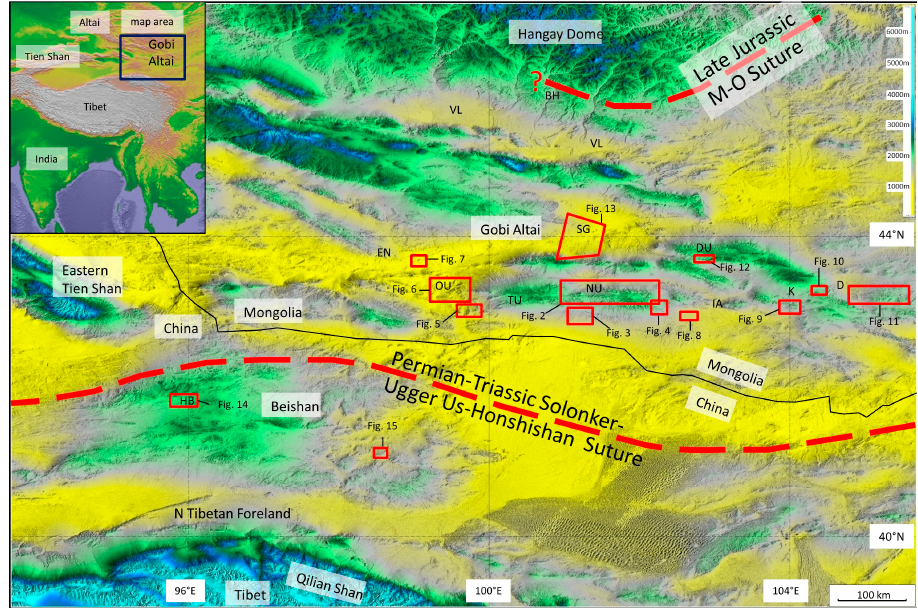
Figure 1. DEM of Gobi Corridor region of southern Mongolia and northern China showing locations of folded basinal compartments (red boxed areas) and subsequent figures (SRTM-90 topographic data). Each location contains contractionally deformed Permian-Jurassic siliciclastic sedimentary rocks unconformably overlain by Cretaceous-Tertiary/Quaternary alluvial sediments that are typically undeformed or less deformed. Locations of Permian Triassic Solonker-Ugger Us-Honshishan suture and Late Jurassic Mongol-Okhotsk suture shown [12,17,18], VL: Valley of Lakes; SG: Sherigyn